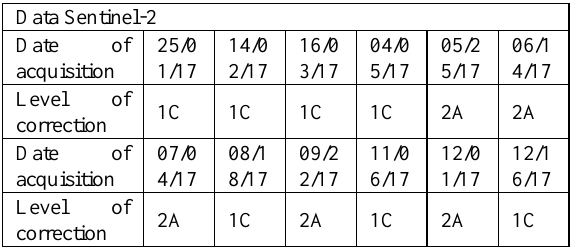
Table 2. Sentinel-2 images available